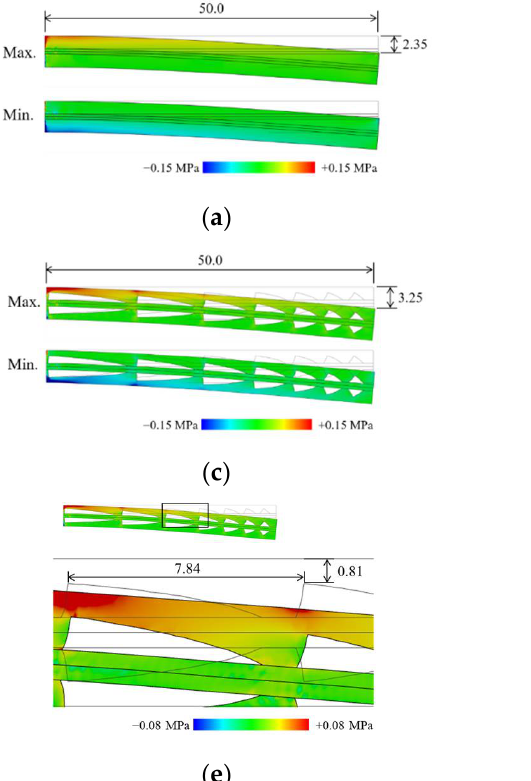
Figure 8. Maximum and minimum principal stress in a high-stiffness state in the four conditions. Homogeneous ( a ), PSL- pitch ( b ), PSL-thickness ( c ) and Pillars ( d ). Magnified images of ( c , d ) with finer stress scales are shown in ( e , f ), respectively. The load size was 0.1 N. The size of maximum vertical deflection in each condition is shown in ( a – d ).